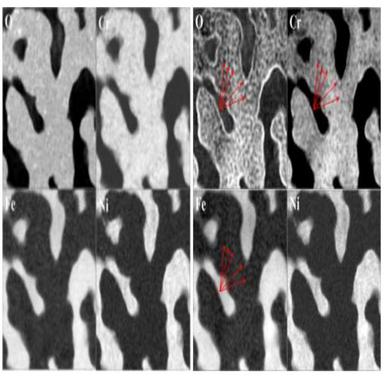
Nanoporosity in the oxide phase. (a) HAADF image showing the two-phase structure of the inner oxide layer (TEM sample 2); (b) quantitative and (c) qualitative EELS chemical composition maps showing the distribution of O, Cr, Fe, and Ni.